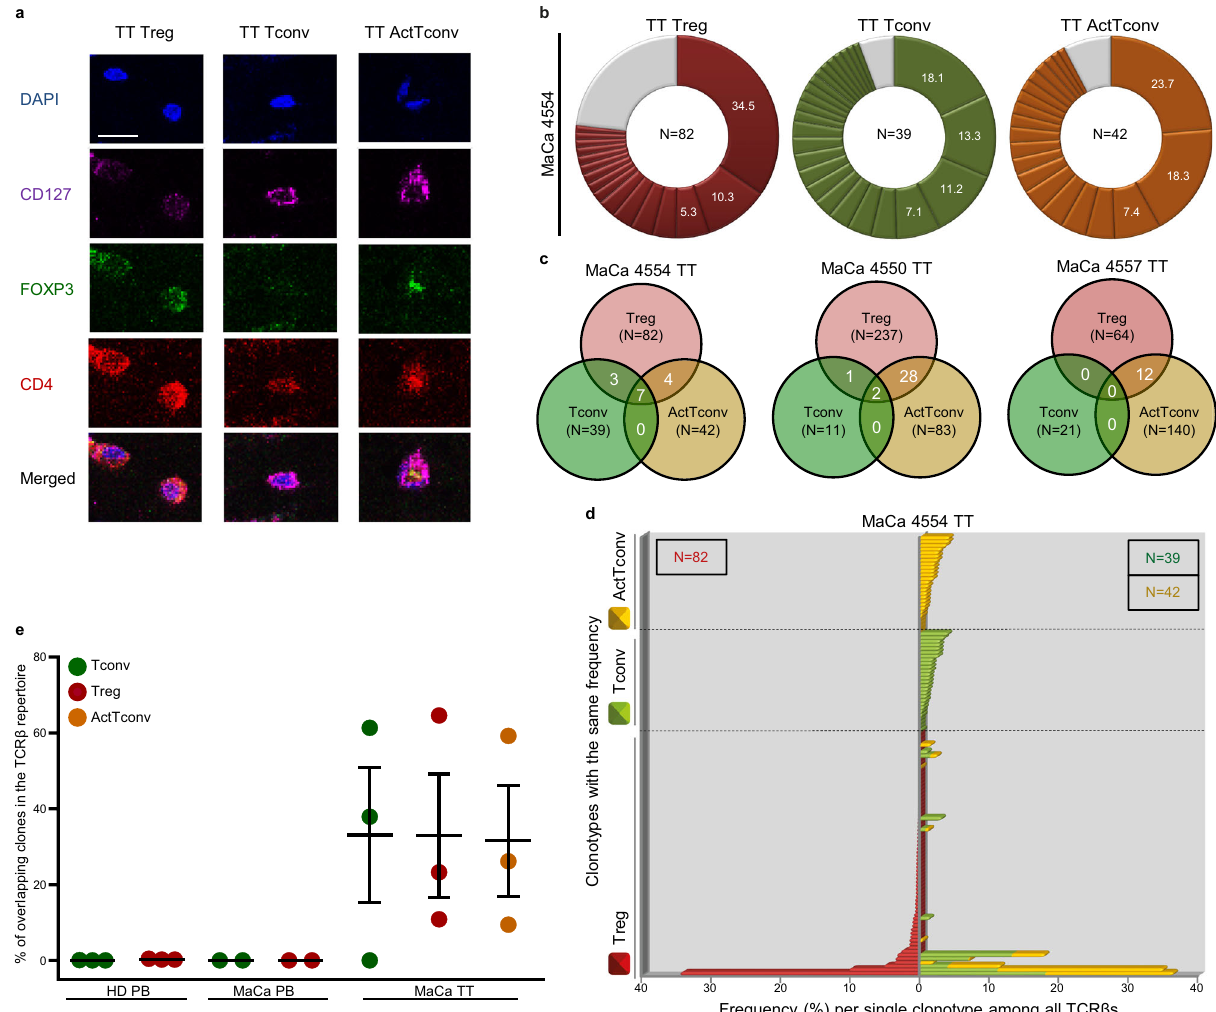
Fig. 6 Major overlap between Treg and Tconv subsets in breast tumors. a Representative immunostaining of FFPE breast tumor tissue (TT) from n = 3 biologically independent replicates. CD4 (red), CD127 (purple), FOXP3 (green), DAPI (blue). TT Treg (CD4 + FOXP3 + CD127 − ), TT Tconv (CD4 + FOXP3 - CD127 + ), TT ActTconv (CD4 + FOXP3 + CD127 + ). Scale bar denotes 2.32 µ m. b Pie chart of all clonotypes (unique TCR β nucleotide sequences) detected among TT Treg (red), TT Tconv (green), and TT ActTconv (orange) in order of decreasing percentage (%). Gray slices correspond to the TCR β repertoire fraction that contains clonotypes with a frequency below 1%. Representative data from breast cancer patient with mammary gland adenocarcinoma MaCa 4554 from n = 3 biologically independent replicates. c Venn diagram of shared clonotypes (white) between TT Treg, TT Tconv, and TT ActTconv within each patient. d Frequency of common clonotypes between TT Treg, TT Tconv, and TT ActTconv in relation to the frequency distribution of all